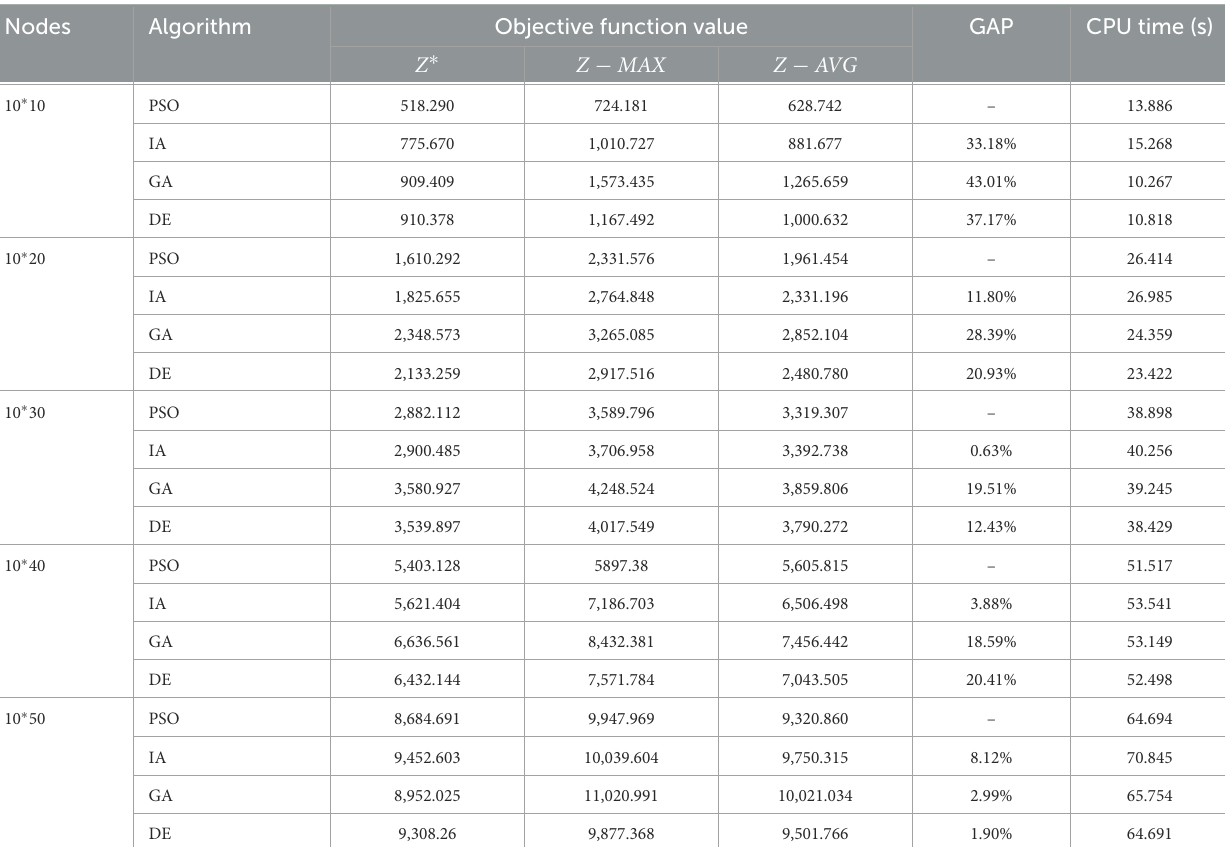
TABLE 6 Scale analysis of the group